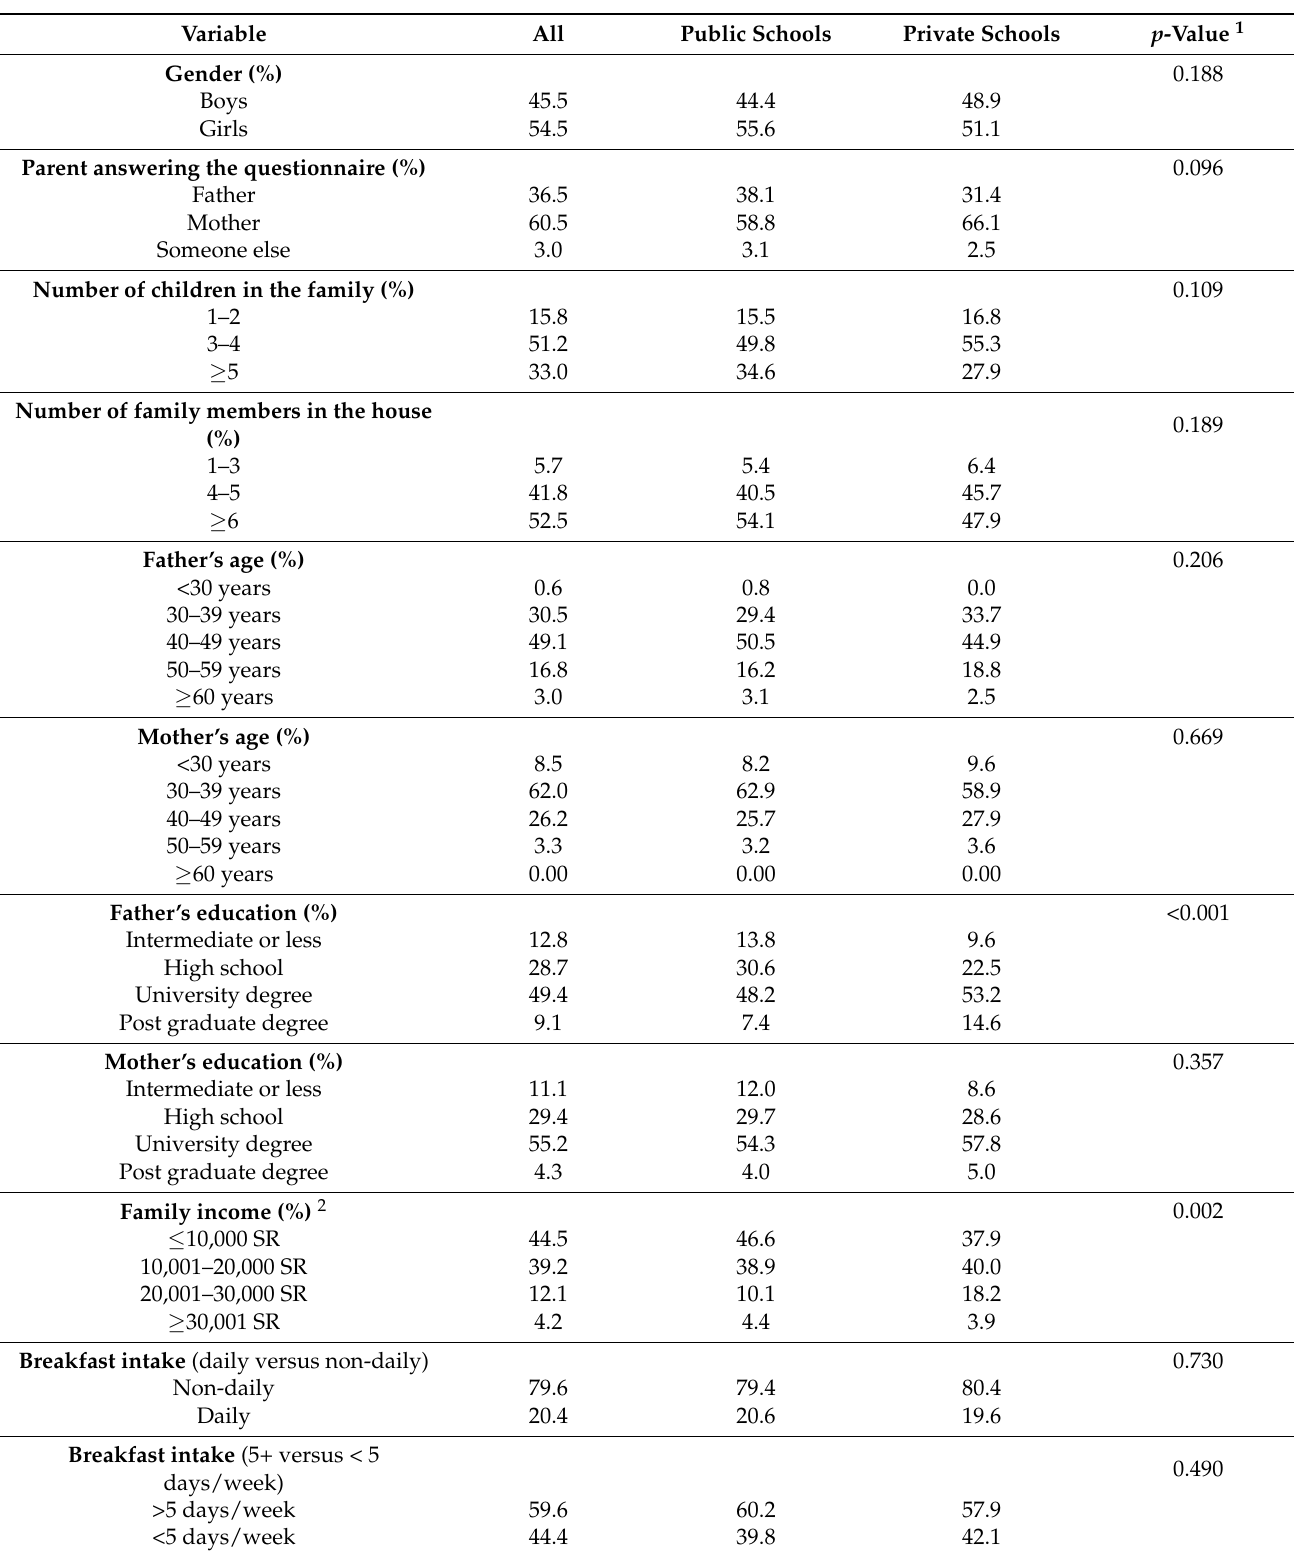
Table 2. Socio-demographic characteristics and lifestyle behaviors of the participants relative to school